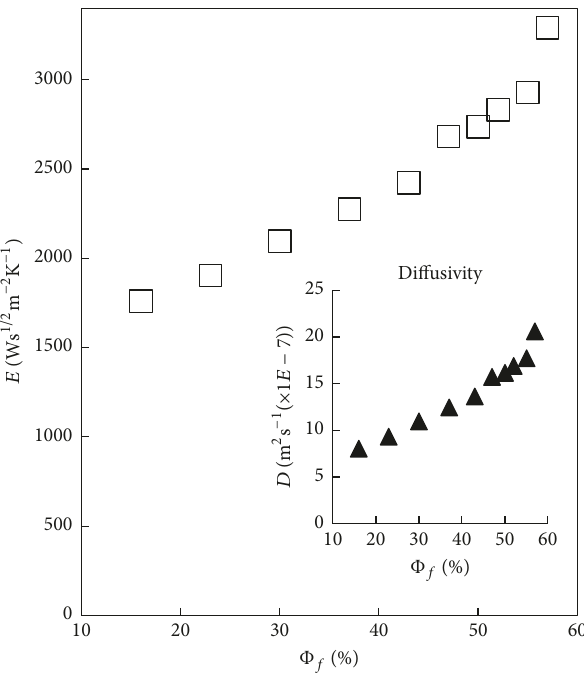
Figure 3: Measured effusivity and calculated diffusivity of P/C versus copper filler content.